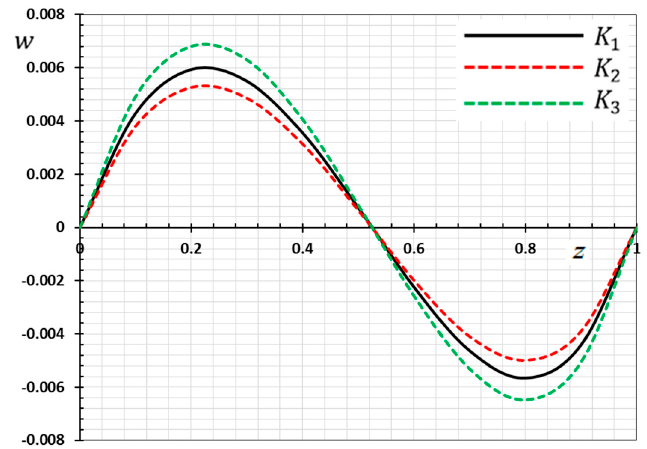
Figure 2. Variation of displacement 𝑤 versus 𝑧 for different forms of kernel function 𝑘(𝑡 − 𝜉) .